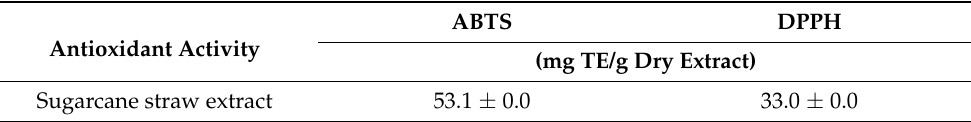
Table 3. Antioxidant activity (means ± SD) of polyphenolic sugarcane straw extract measured through ABTS and DPPH. ABTS DPPH Antioxidant Activity (mg TE/g Dry Extract) Sugarcane straw extract 53.1 ±